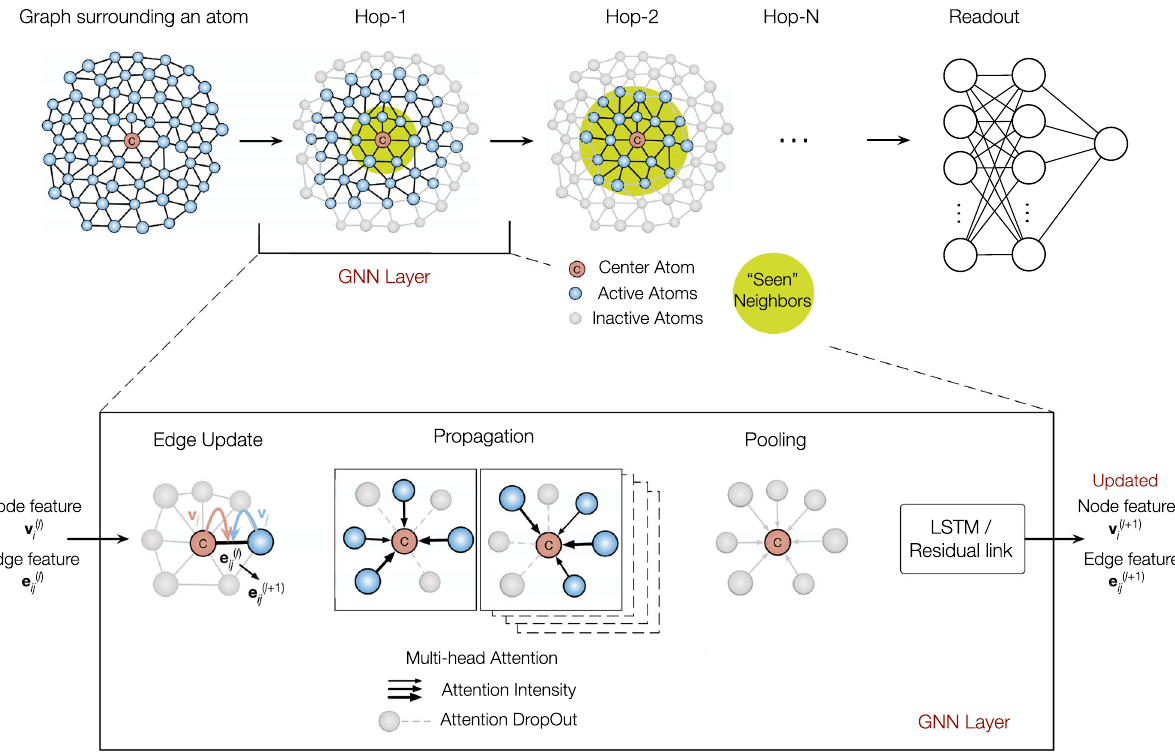
Fig. 1 Architecture of graph neural networks. Starting from the glass graph with nodes as atoms and edges as interatomic interactions, the graph networks are stacked with N layers, allowing messages passing through hop- N neighboring layers around each atom. Finally, a readout layer is set up to get the property (regression) or the possibility of belonging to a class (classi fi cation). The processing procedure inside a GNN layer is highlighted in the lower